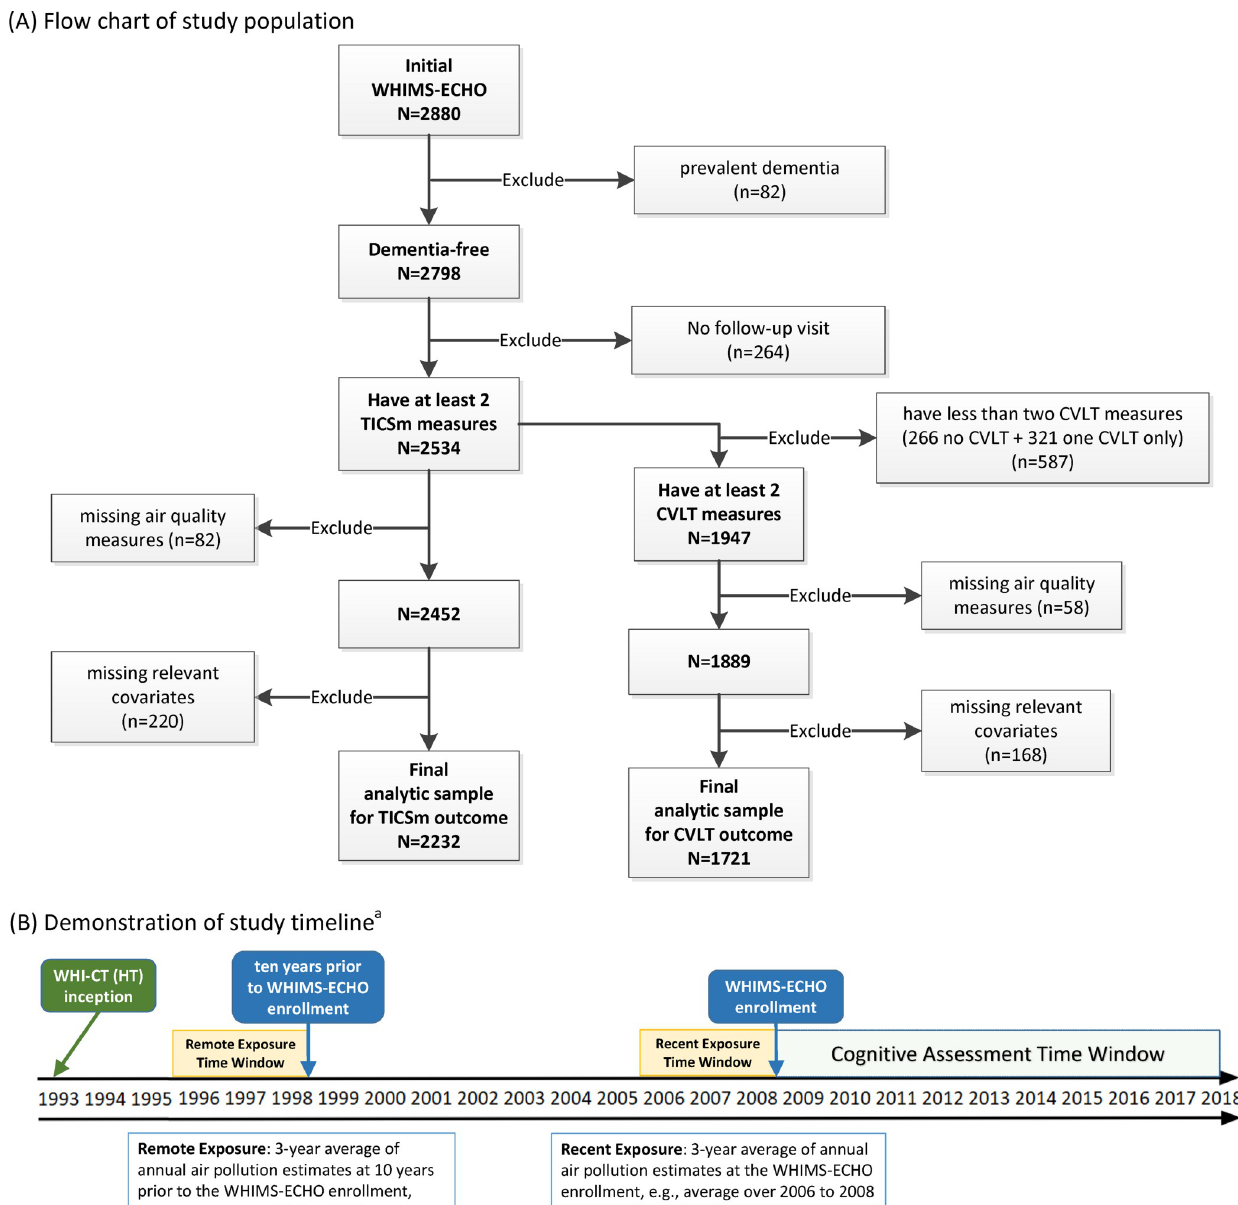
Fig 1. Flowchart of study population and demonstration of study timeline. (A) Flowchart of study population. (B) Demonstration of study timeline. a a The exposure time windows may vary slightly depending on each individual’s WHIMS-ECHO enrollment time. CVLT, California Verbal Learning Test; TICSm, modified Telephone Interview for Cognitive Status; WHI-CT (HT), Women’s Health Initiative-Clinical Trial (Hormone Therapy); WHIMS-ECHO, Women’s Health Initiative Memory Study-Epidemiology of Cognitive Health Outcomes.